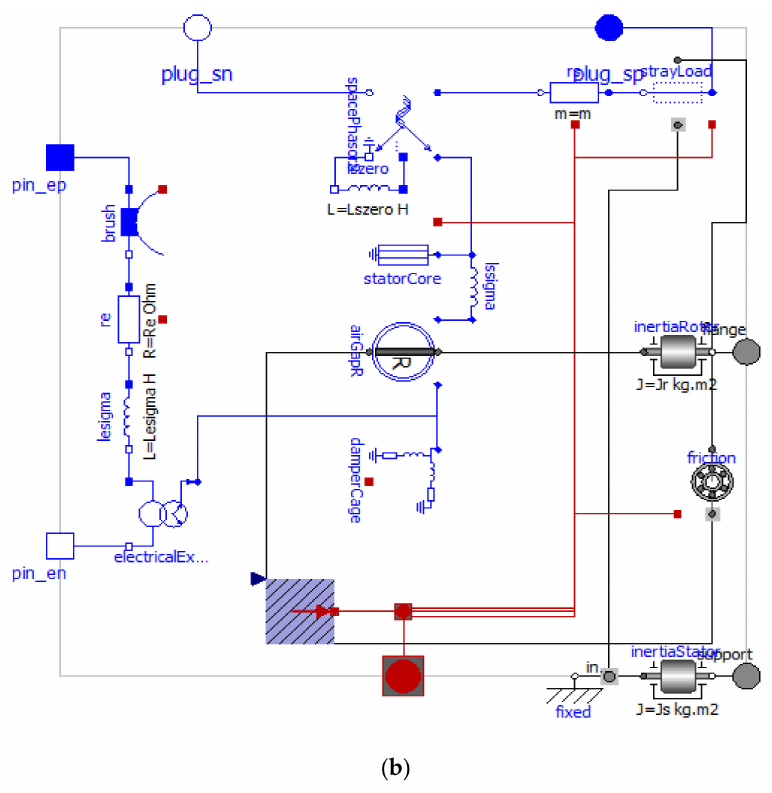
Figure 2. Diagram of the simulation in the OpenModelica program: ( a ) responsible for loading the tested brake with the required courses of torque and angular speed in accordance with driving tests; ( b ) model of a three-phase electrically excited synchronous induction machine with a damping